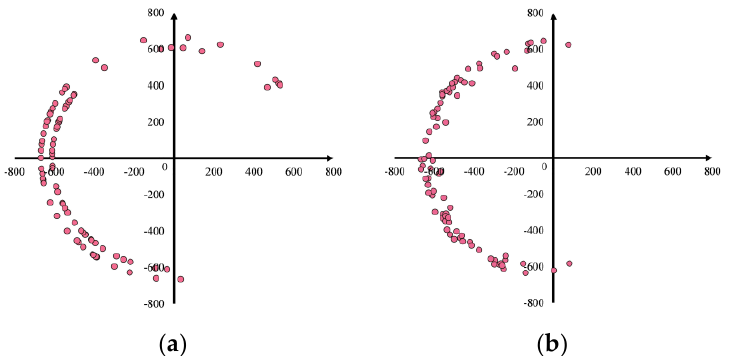
Figure 8. Extraction of curves’ shape feature point: feature description sequence of ( a ) curve A and ( b ) curve B .